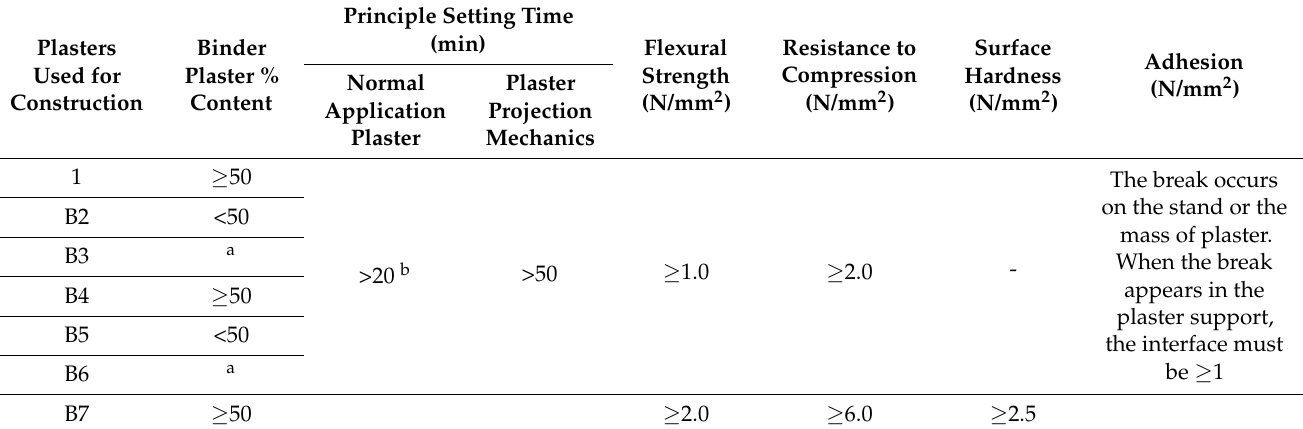
Table 2. Specifications for construction plasters (source: UNE EN 13279-2)